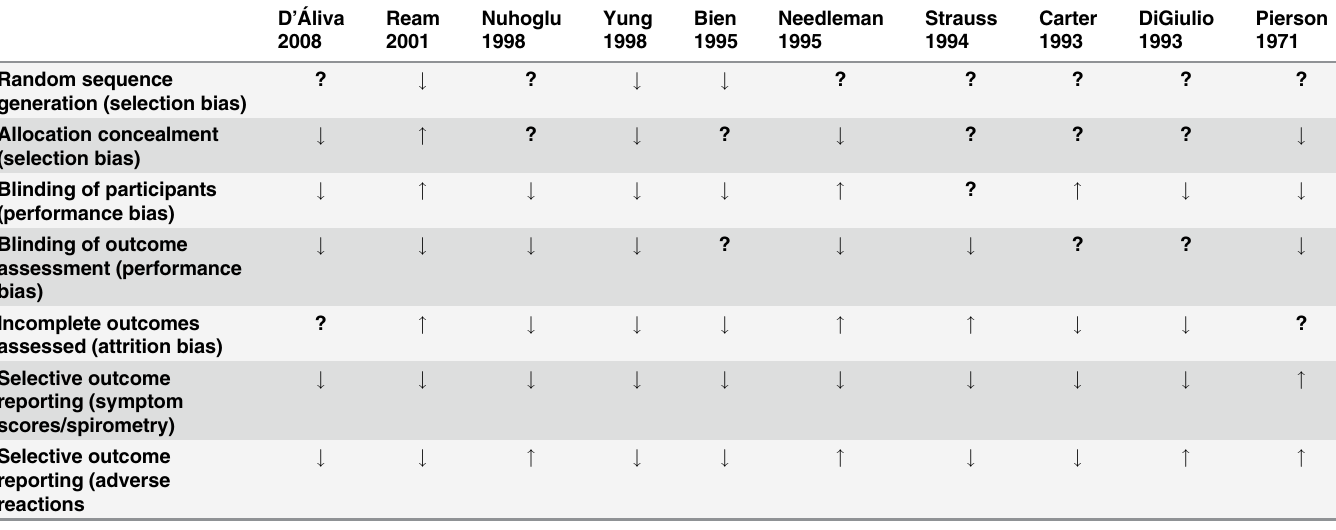
Table 1. Assessment of risk of bias in included studies using Cochrane tool.